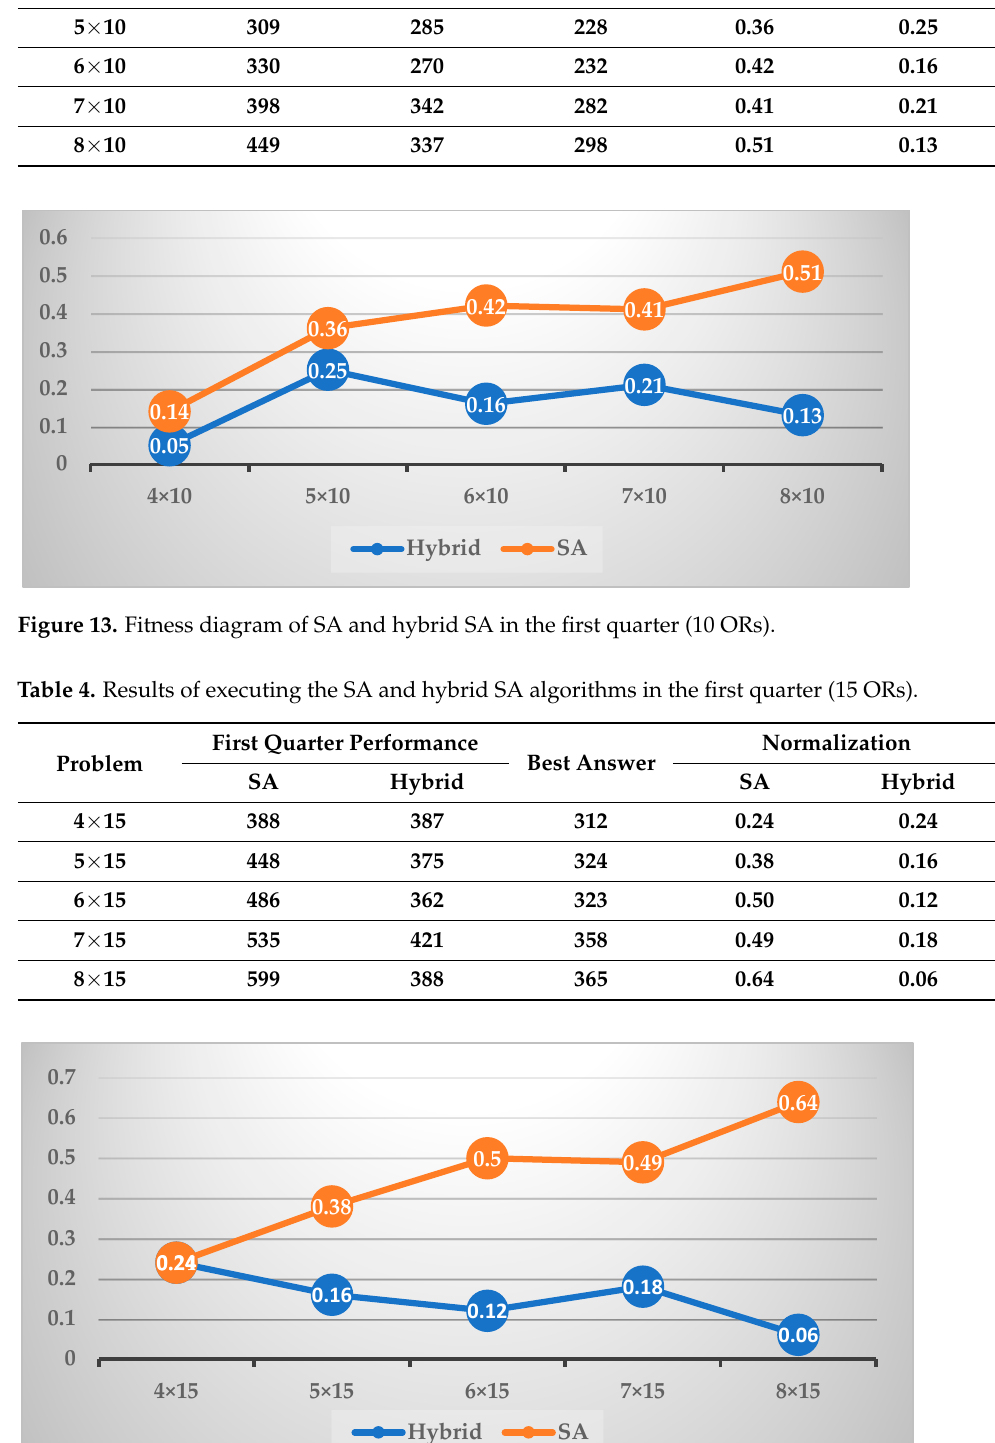
Figure 14. Fitness diagram of SA and hybrid SA in the first quarter (15 ORs). Table 5. Results of executing the SA and hybrid SA algorithms in the second quarter (10 ORs) .